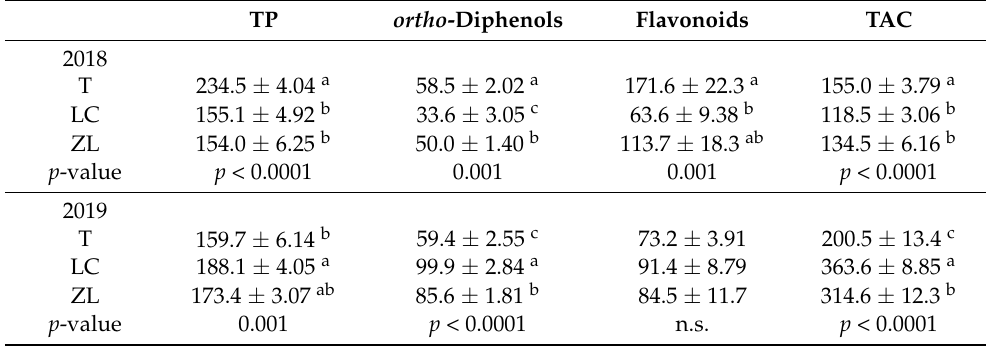
Table 3. Olive oil metabolite concentration as a function of soil management treatment and harvest